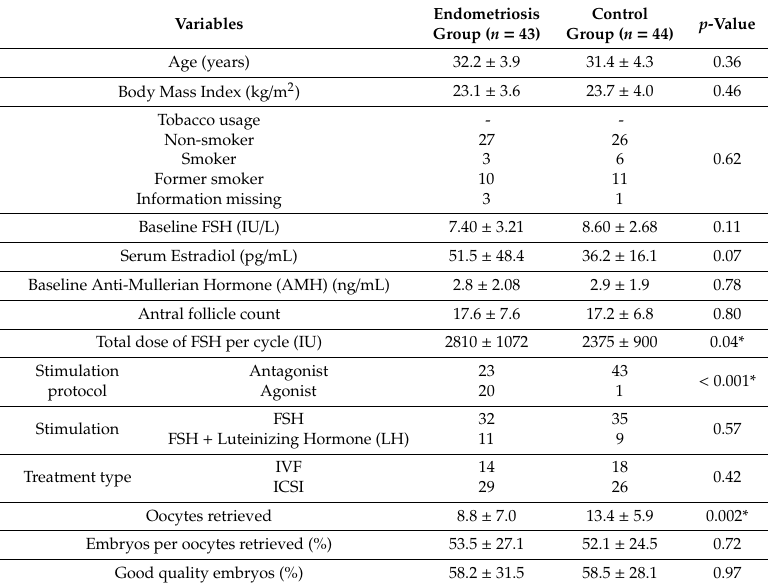
Table 1. Baseline characteristics of patients and